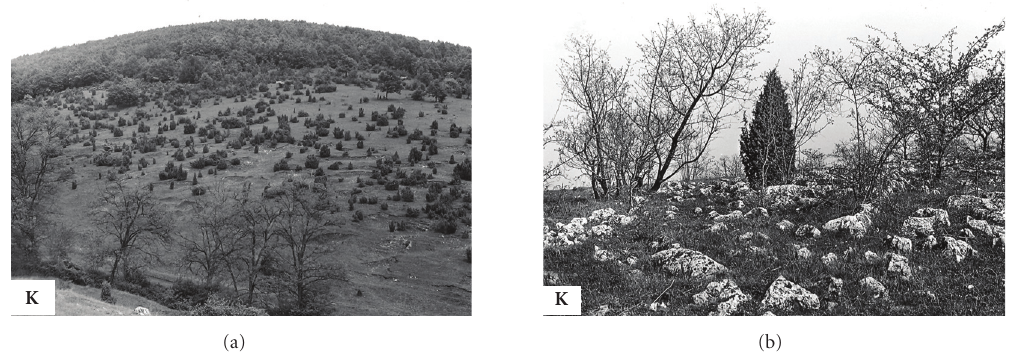
Figure 5: Natural focus of Bhanja virus infections in southeastern Slovakia (Slovak Karst at Keˇcovo, K